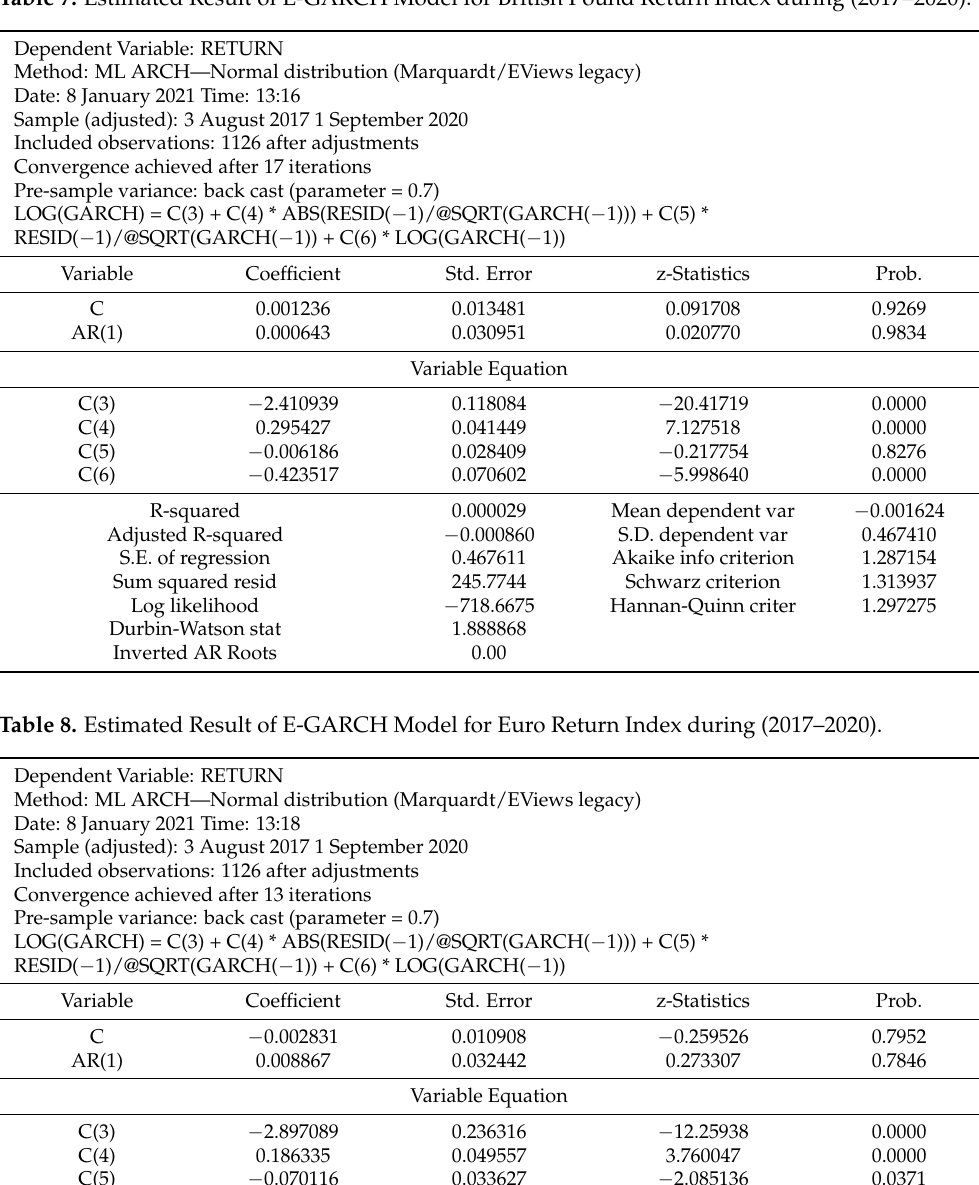
Table 7. Estimated Result of E-GARCH Model for British Pound Return Index during (2017–2020).